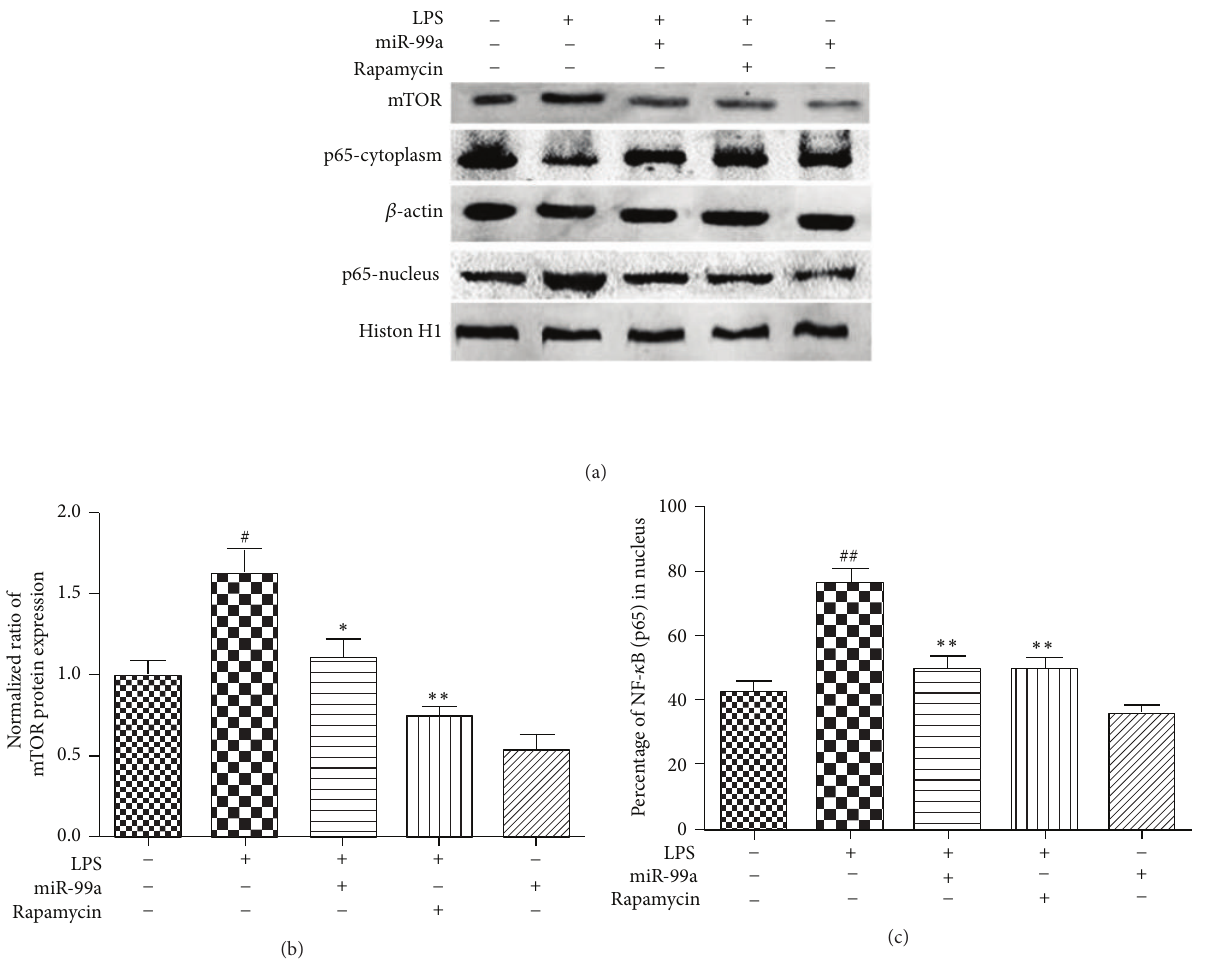
Figure2:EffectsofmiR-99aonLPS-inducedmTORexpressionandNF- 𝜅 Bnucleartranslocation.EndothelialcellsweretransfectedwithmiR- 99a (100nM) mimic or rapamycin (50 nM) for 24 hours and then treated with LPS (20 𝜇 g/mL) for another 24 hours. The protein levels were detected by Western-blot. (a) The expression of different proteins analyzed by Western-blot; (b) quantified band density for mTOR relative to control, which was set as 1; (c) percentage of NF- 𝜅 B in nucleus, total NF- 𝜅 B presented by the summary of quantified band density for NF- 𝜅 B (cytoplasm) and NF- 𝜅 B (nucleus). All values are presented as mean ± SD from three independent experiments. # 𝑃 < 0.05 ; ## 𝑃 < 0.01 versus control; ∗ 𝑃 < 0.05 ; ∗∗ 𝑃 < 0.01 versus